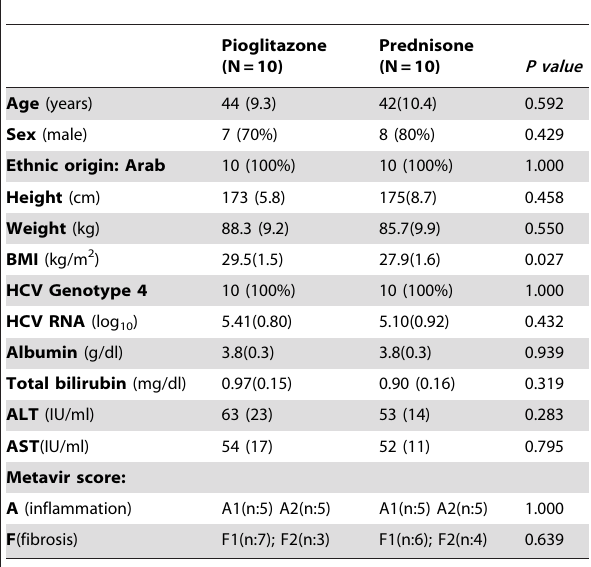
Table 1. Baseline demographic and clinical characteristics of treated subjects.